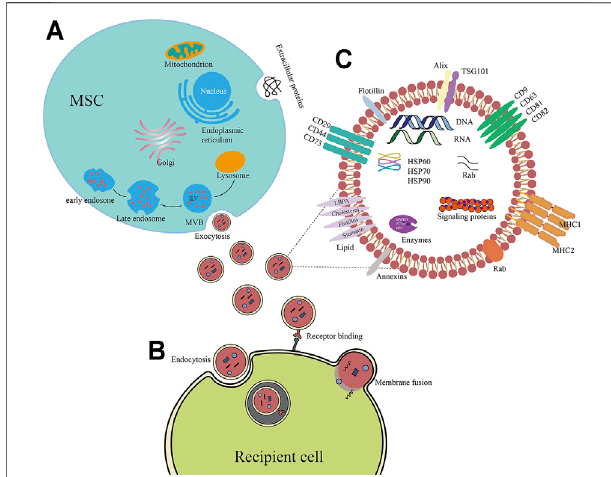
FIGURE2|(A) Themolecularcompositionofexosomesgeneratedfrom MSCs. Exosomes generated from MSC contain adhesion molecules (CD73, CD44, and CD29), tetraspanins (CD9, CD63, and CD81), multivesicular body biogenesis-related proteins (Tsg101, Alix), and heat shock proteins. In addition to proteins, exosomes also comprise enzymes, lipids, and nucleic acids (DNA, miRNA, microRNA, and mRNA). (B) Biogenesis of exosomes produced from MSCs. As exosomes, these vesicles of endocytic origin are generated when the multivesicular body (MVB) membrane is subjected to inward budding, resulting in the formation of exosomes. ILV is found in MVBs. The production of exosomes occurs as a consequence of the fusion of MVBs with their plasma membrane. (C) Exosomes may in fi ltrate target cells by a variety of pathways, including membrane fusion, binding receptors, and